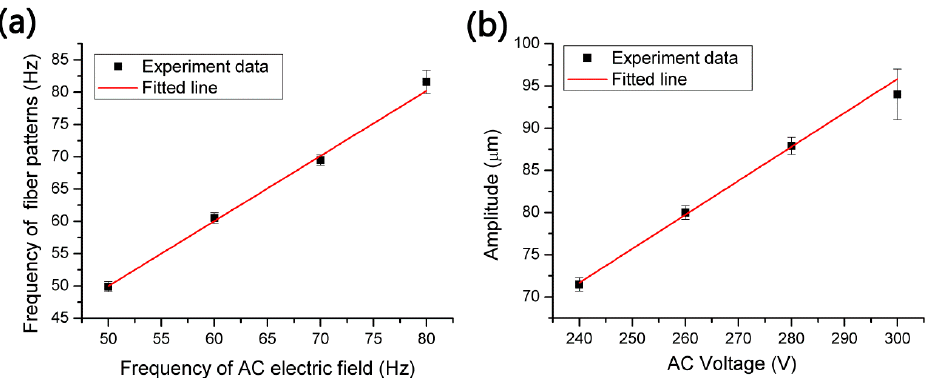
Figure 3. ( a ) Correlation between fiber patterns frequency and AC electric field frequency, and the nanofibers deposited in the following conditions: AC voltage 300 V, DC voltage 1.3 kV, PEO concentration 8%, electrode-to-collector distance 5 mm, collector speed 5 mm/s and the nozzle to auxiliary electrodes distance is 6 mm; ( b ) Correlation between fiber patterns amplitude and AC voltage. The parameters are the same as (a), but the nozzle to auxiliary electrodes distance is 7 mm and the frequency of AC voltage applied is 50